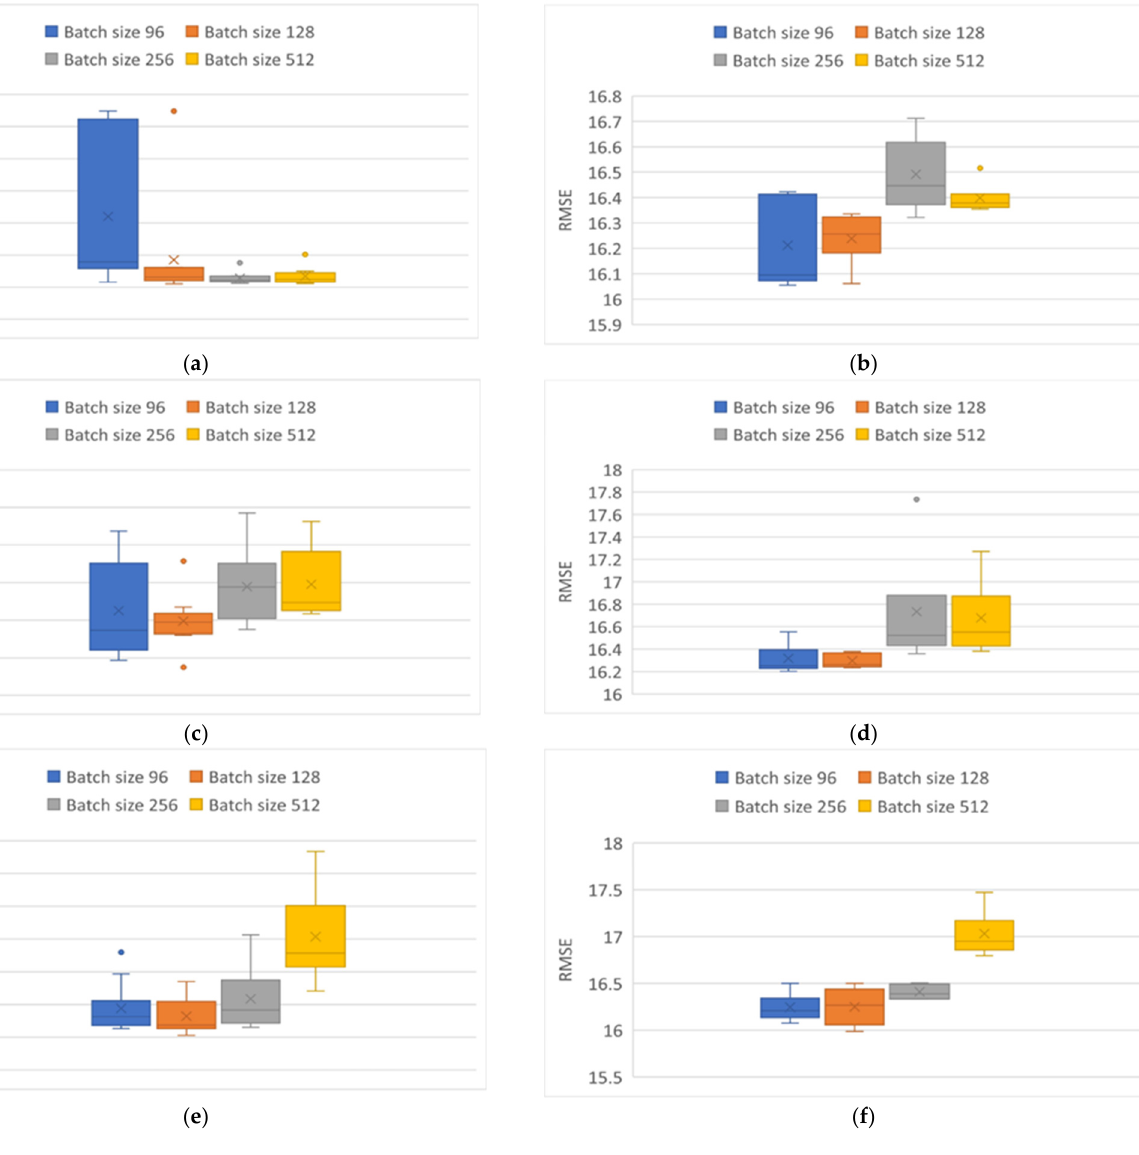
Figure 11. RMSE variability obtained from modeling PM 10 particles. ( a ) Elman neural network using Adam optimizer. ( b ) Elman neural network using Adamax optimizer. ( c ) GRU neural network using Adam optimizer. ( d ) GRU neural network using Adamax optimizer. ( e ) LSTM neural network using Adam optimizer. ( f ) LSTM neural network using Adamax optimizer.